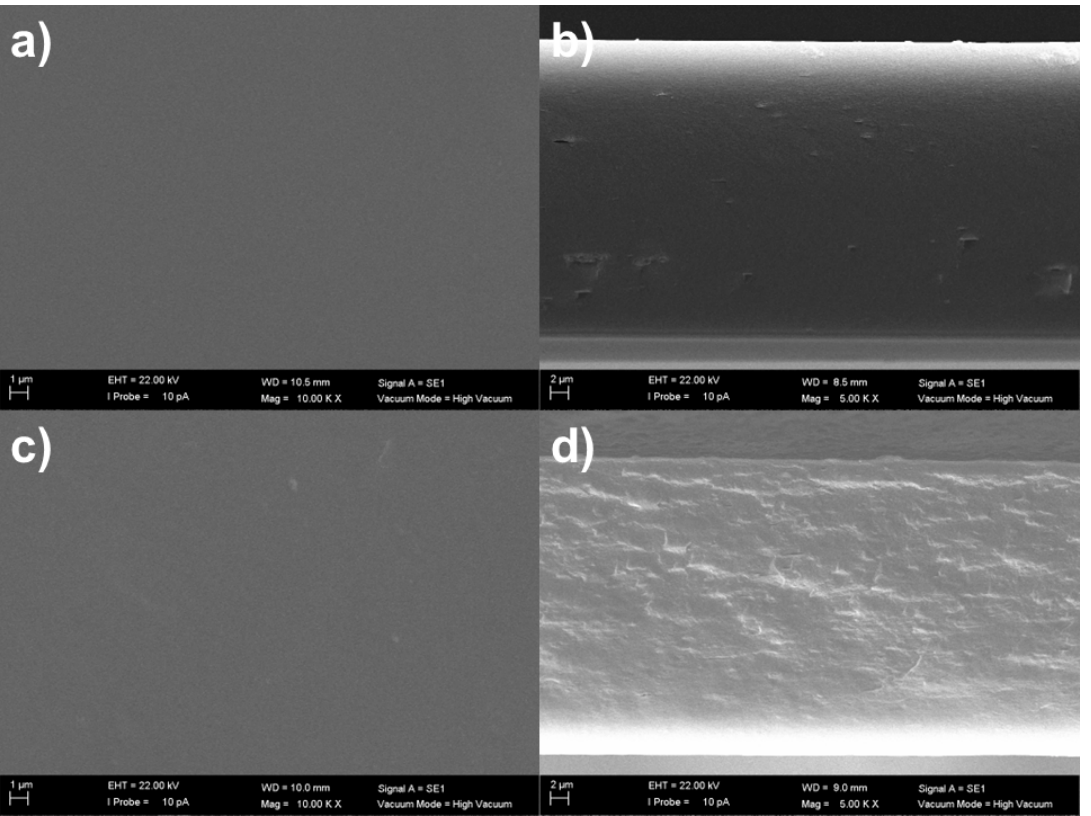
Figure 3. SEM surface and cross-section view images of the fabricated membranes based on CS and L-proline:xylitol DES. ( a , b ) crosslinked chitosan and ( c , d ) crosslinked chitosan:L-proline: xylitol (CS:PRO:XYL).